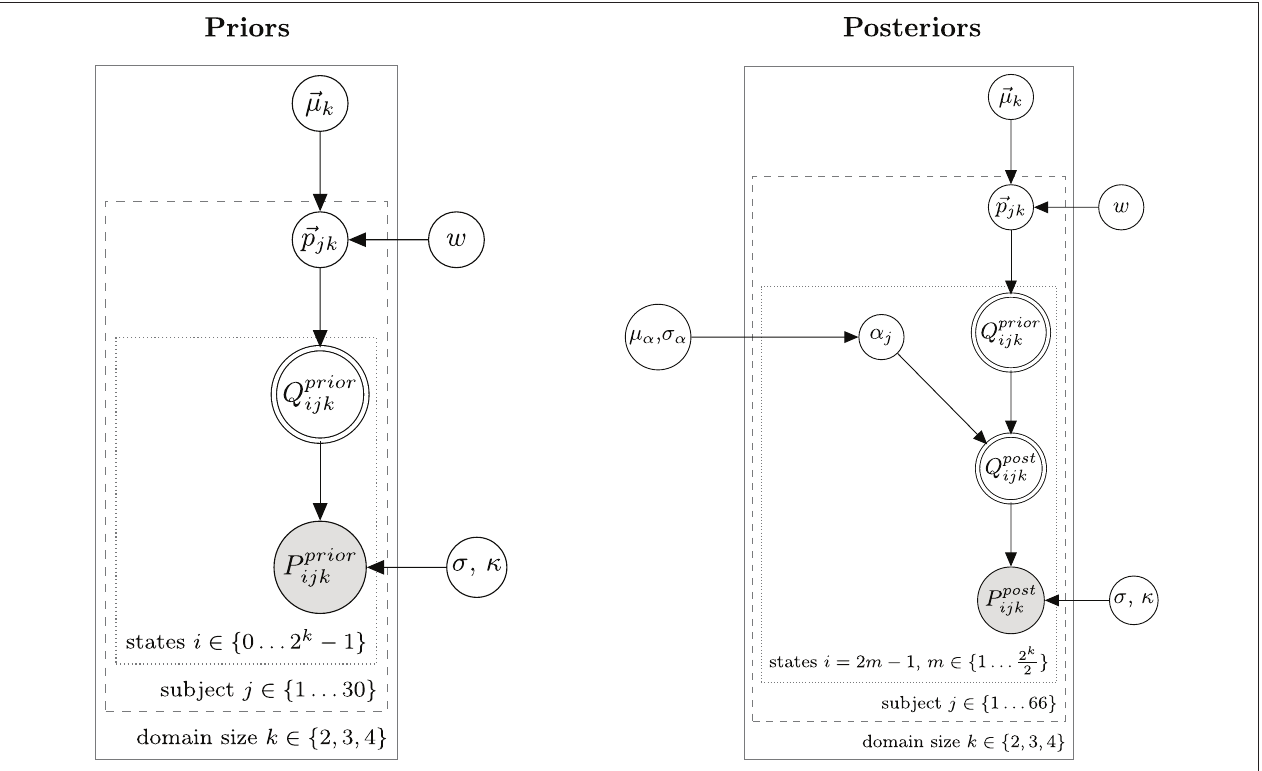
FIGURE 3 | Bayesian graphical models for prior probabilities (left) and posterior probabilities (right) used for data analysis in Experiment 1.